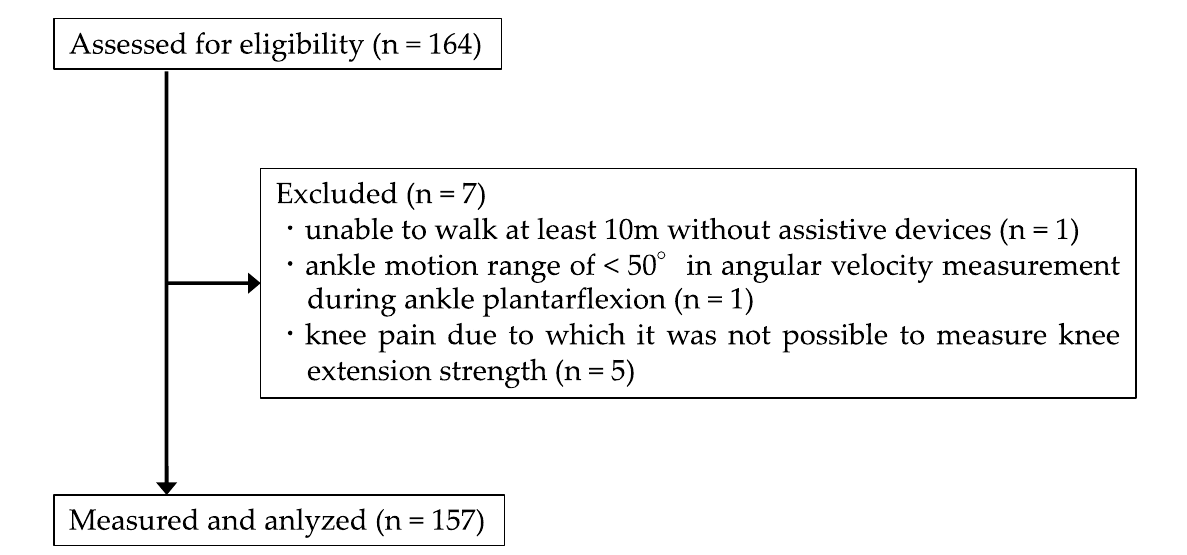
Figure 3. Flowchart depicting the selection of study participants. Table 1. Characteristics of participants ( n = 157).